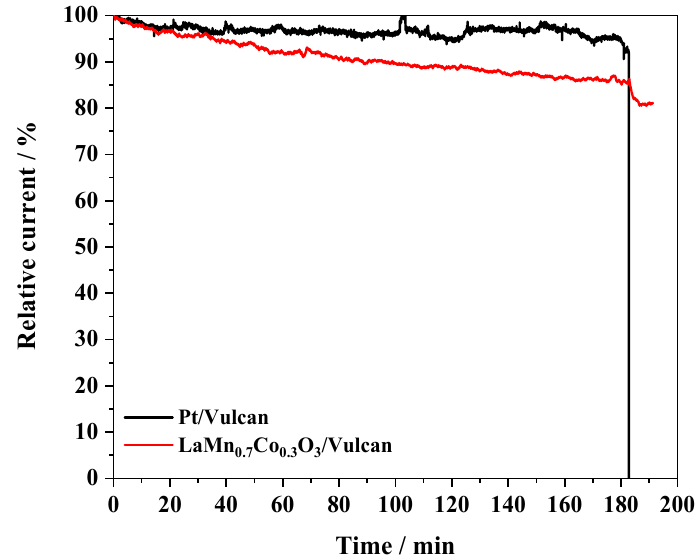
Figure 7. Comparative stability test for LaMn 0.7 Co 0.3 O 3 / Vulcan (1:1 mass ratio) and 20% Pt / Vulcan carried out at 0.65 V and 1600 rpm in O 2 -saturated 0.1 M KOH and 25 °C. Methanol was added 180 min after the beginning of the experiment.